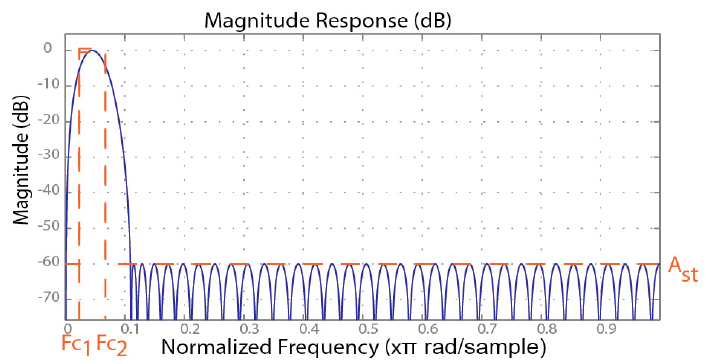
Figure 4. Band-pass finite impulse response (FIR) filter adjusted by changing the sampling frequency.